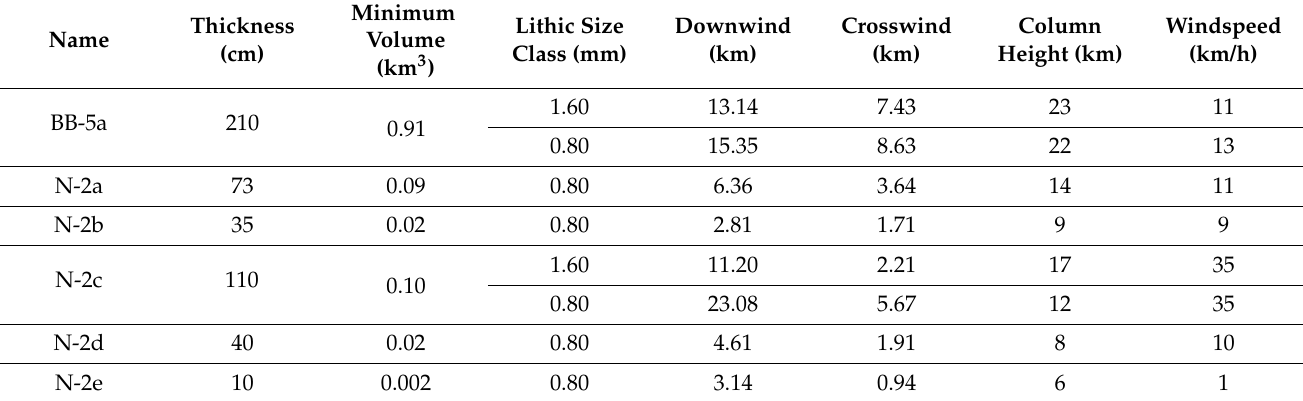
Table 1. Isopach, column height, and windspeed parameters.